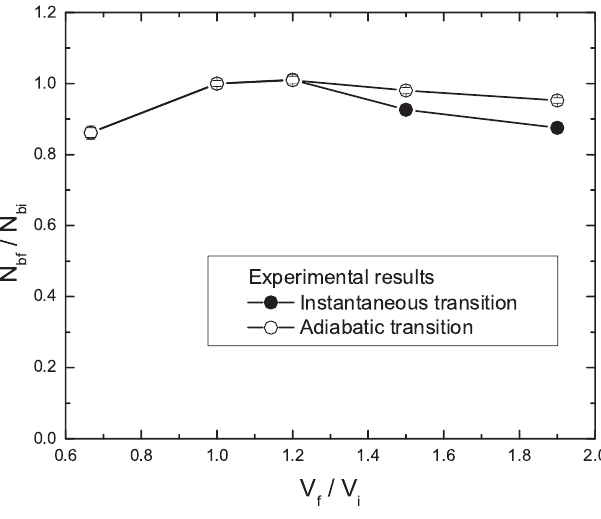
=N bf bi =N are mea- bf bi (cid:2) vi